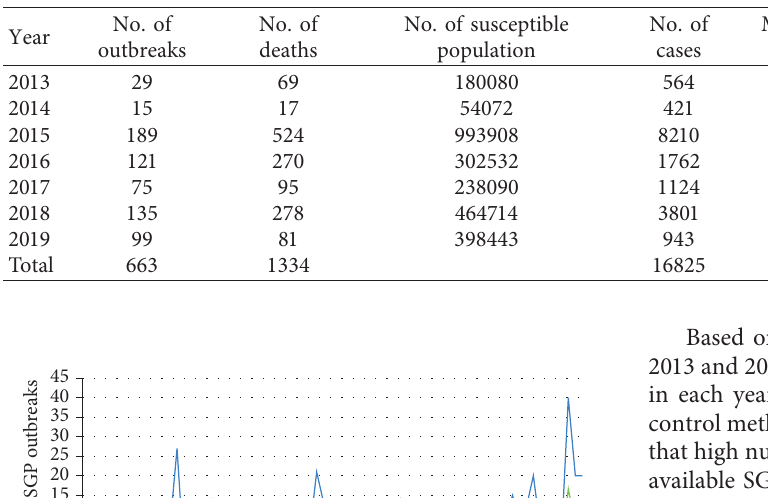
Table 4: Annual statistics of SGP outbreak in Eastern Amhara region from September 2013 to December